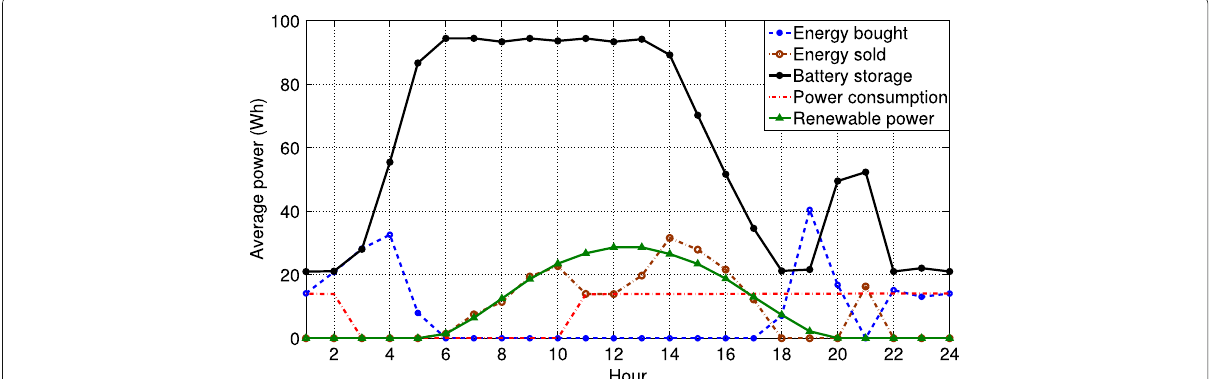
Fig. 7 Energy transaction, consumption, production, and storage with the ideal strategy under C 3 , averaged over 5